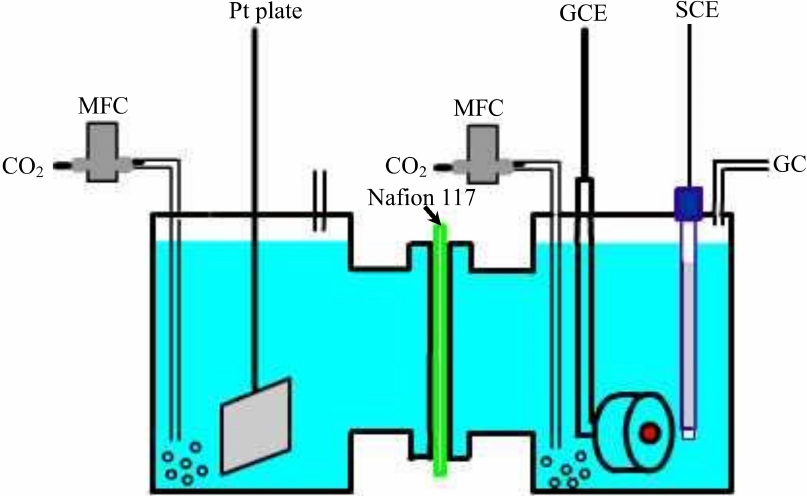
Figure 1. Schematic illustration of three-electrode electrochemical